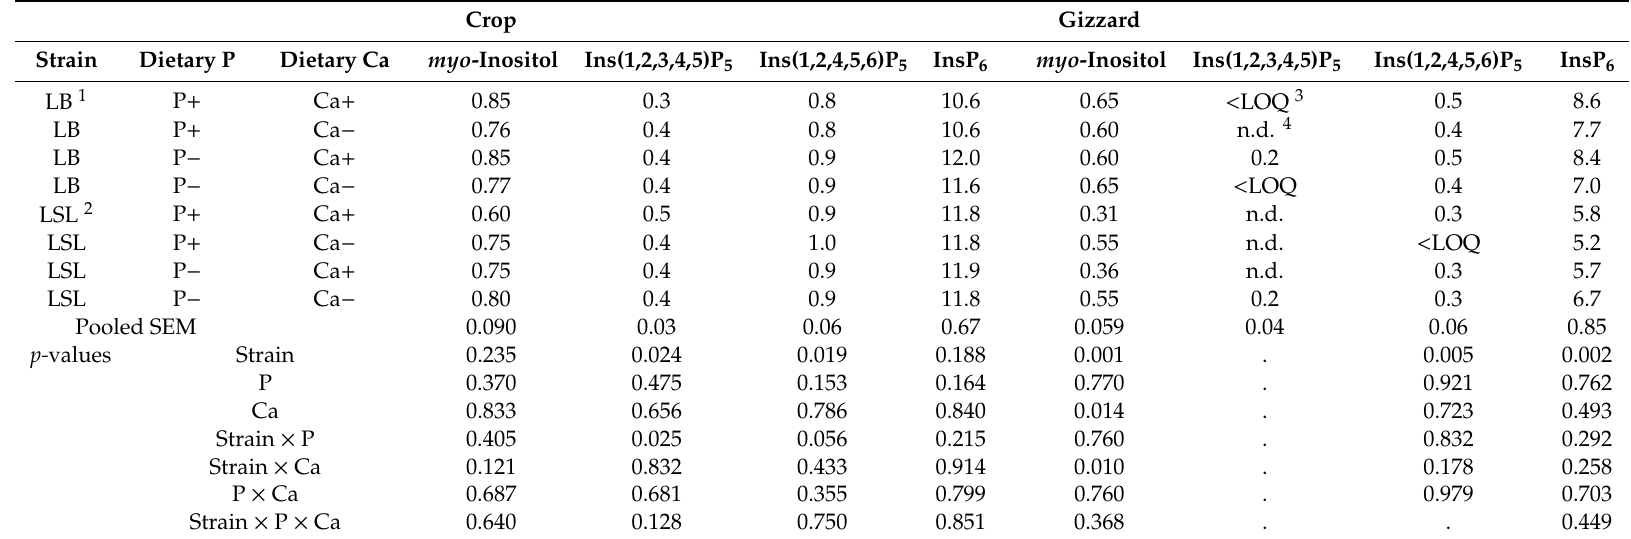
Table 3. E ff ect of strain, P, and Ca on concentrations of myo -inositol and InsP isomers in the crop and gizzard of laying hens aged 31 weeks ( µ mol / g). Crop Gizzard Strain Dietary